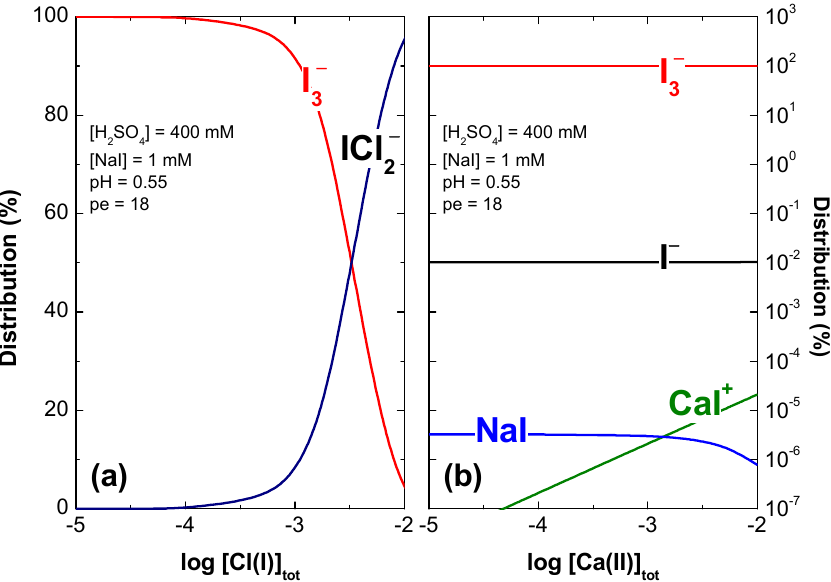
Figure 5. Species distribution of iodine for various ( a ) Cl − and ( b ) Ca 2+ concentrations. Note that the y -axis of the left-hand side figure is in linear scale, and that of the right-hand side figure is in log scale.